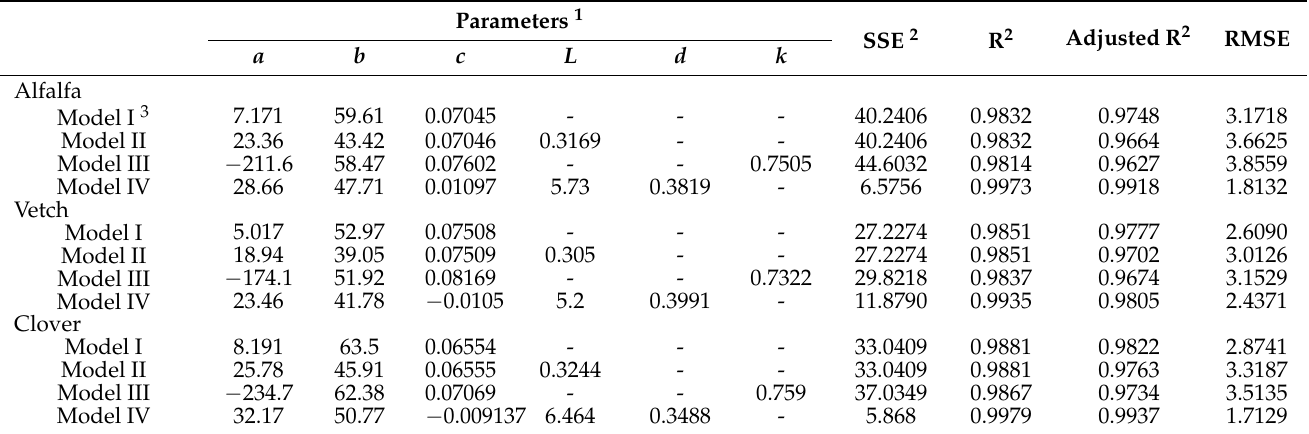
Table 2. In vitro gas production parameters of legume forages using a mathematical model fitted with